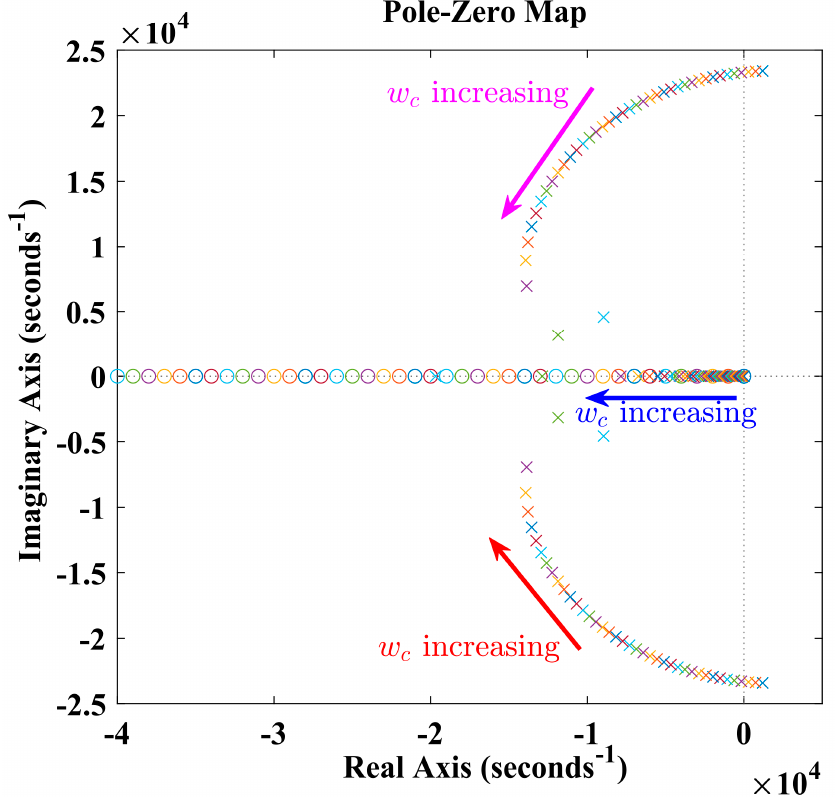
Figure 10. Pole-zero maps of 𝑉 (cid:3042) (𝑠) 𝑑(𝑠)⁄ given in (10) [86].